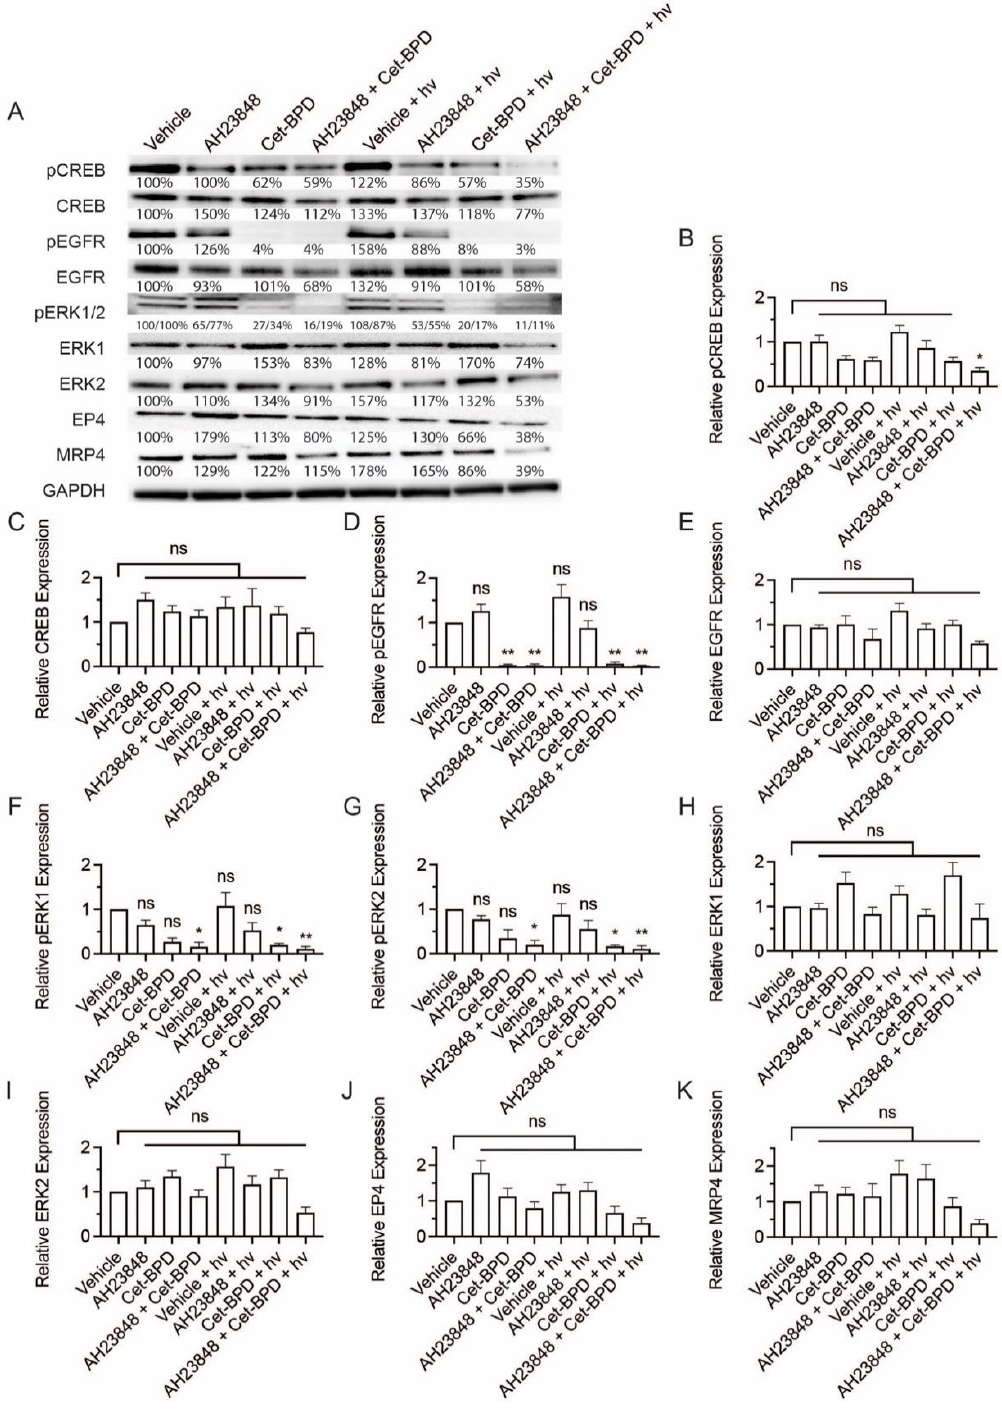
Figure 5. Western blot analysis of p-CREB, CREB, p-EGFR, EGFR, p-ERK1/2, ERK1, ERK2, EP4, and MRP4 in OVCAR-5 cells. Cells were treated with the indicated agents for 24 h, then light-activated (0.1 J/cm 2 , 10 mW/cm 2 ) or maintained in dark conditions. After 24 h, cells were agonized with EGF (50 ng/mL) and PGE 2 (1 µM) for 10 min, then whole extracts were collected and analyzed using Western blot. ( A ) Representative Western blot images and ( B – K ) relative